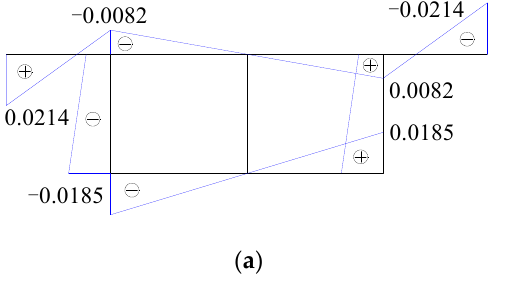
Figure 10. Geometric characteristics of the section (unit: 10 − 5 m 4 ): ( a )